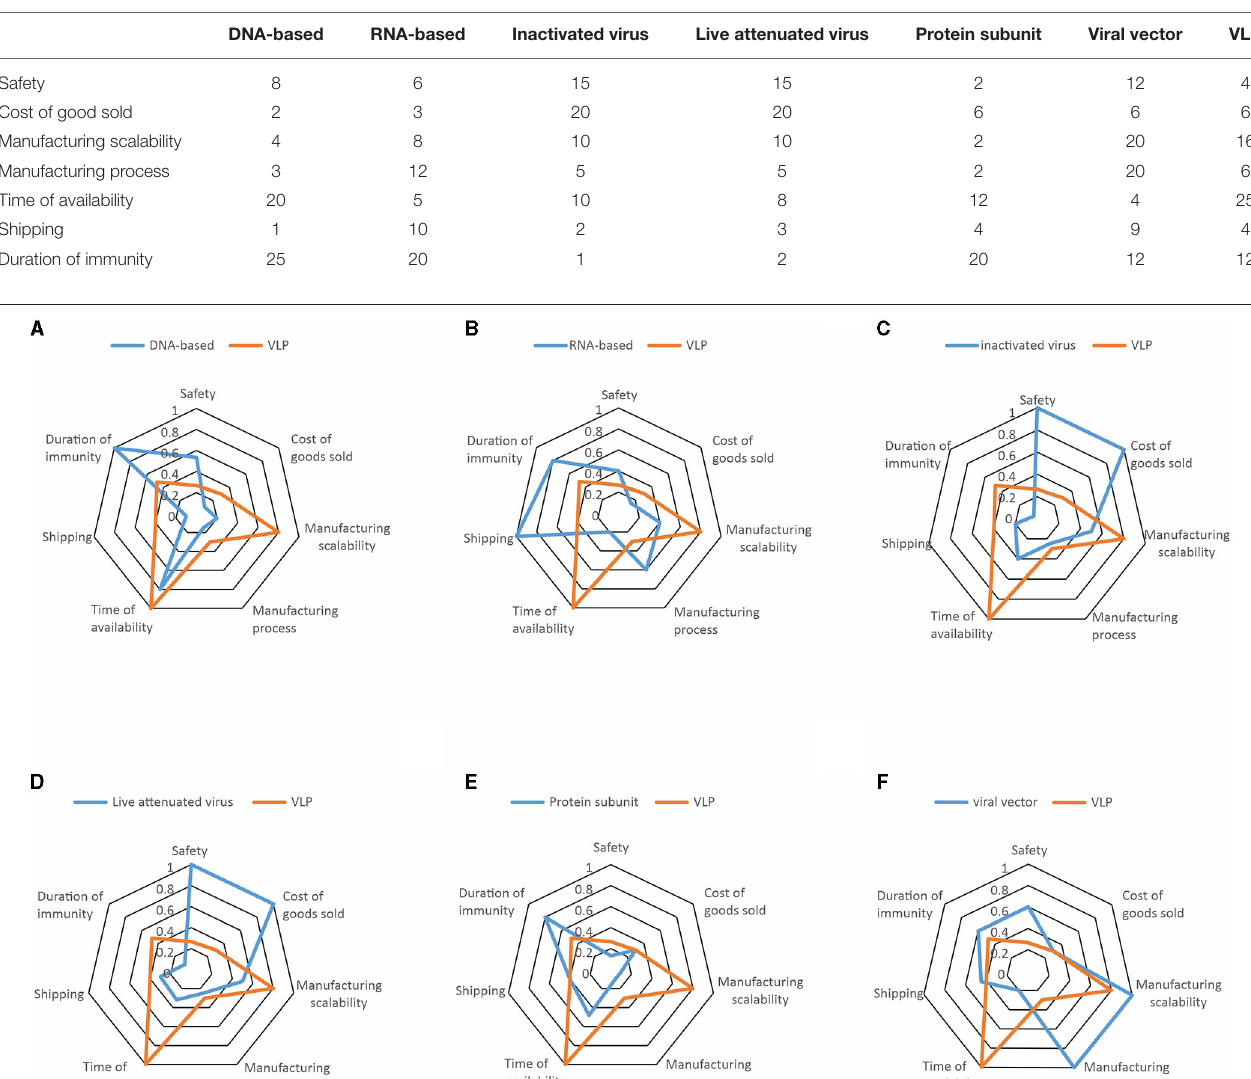
reach more than 100 million doses before 2022 (16). This